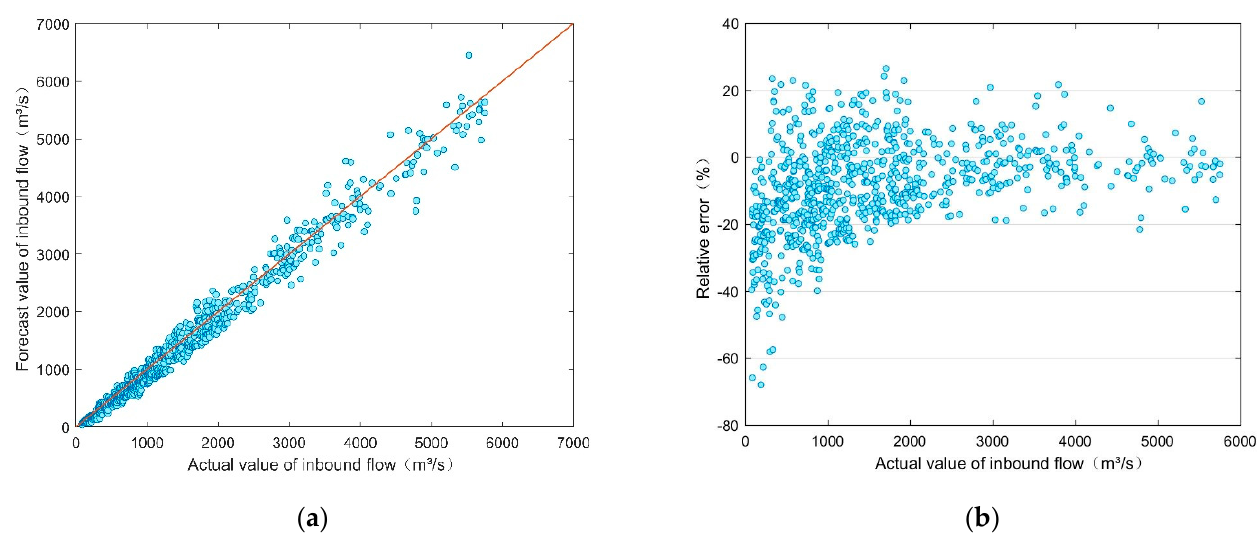
Figure 8. ( a ) Relationship between actual inbound flow and forecasted flow; ( b ) Relationship between actual inbound flow and relative error.